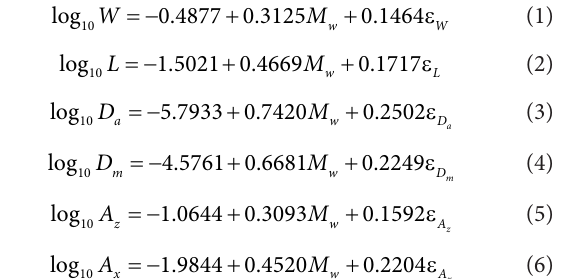
The equations for the Box–Cox parameter and the Hurst number are independent of M w (Goda et al., 2016). The Box–Cox parameter is modeled as a normal random variable with mean equal to 0.312 and SD equal to 0.278. On the other hand, the Hurst number is modeled as a random variable that takes a deterministic value of 0.99 with probability of 0.43 and a sampled (random) value from the normal distribution with mean equal to 0.714 and SD equal to 0.172 with probability of 0.57. See Goda et al. (2016) for further details of the probabilistic models of the source parameters. The prediction errors of the Box–Cox param- eter/Hurst number are considered to be uncorrelated with those of other source parameters.